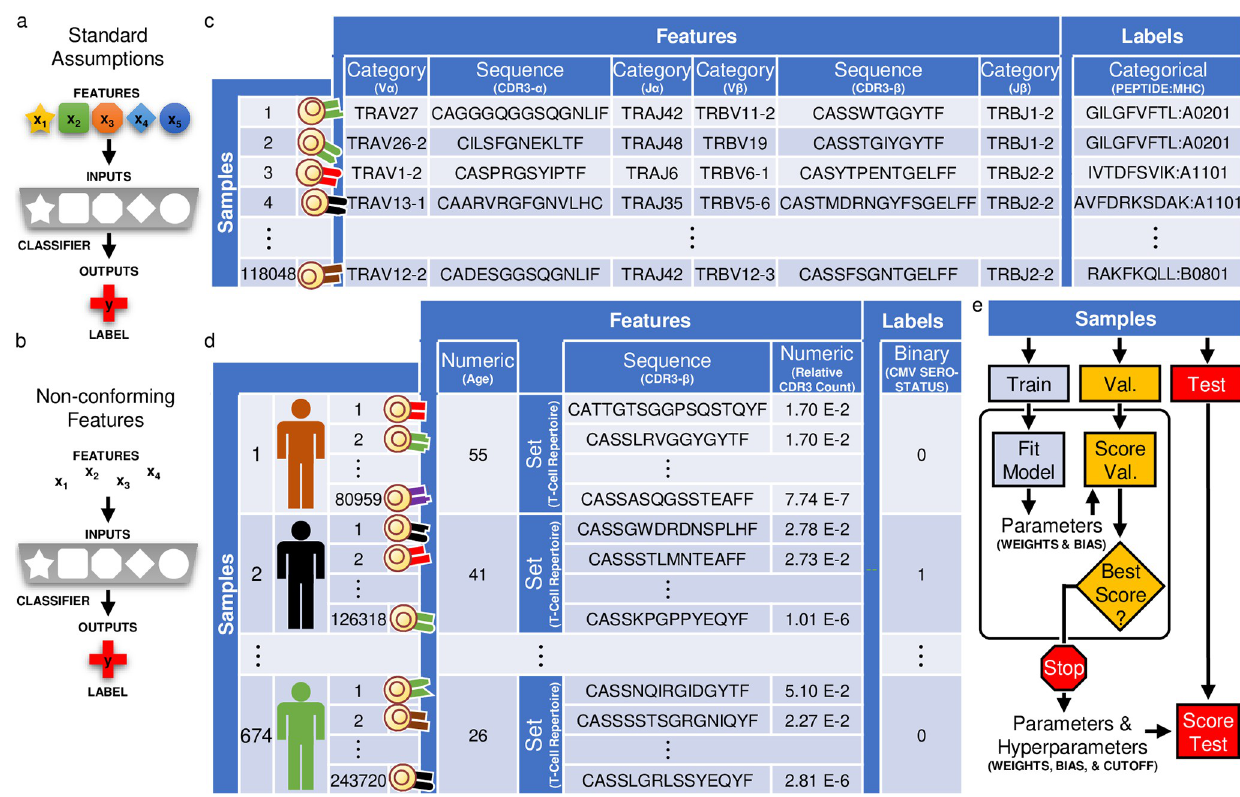
Fig 1. TCRs are examples of non-conforming data. (a) Most statistical classifiers assume a fixed number of features (e.g. five) and that each feature represents the same kind of information across samples (e.g. shape). (b) These assumptions do not hold for non-conforming data. (c) A dataset of TCRs labelled by interaction with disease antigens. The dataset contains the amino acid symbols from regions of the TCR (CDR3) represented as sequences, which are examples of non-conforming data. (d) A dataset of TCR repertoires labelled by CMV serostatus. The dataset contains sequenced TCR repertoires represented as sets made of sequences, which is a different kind of non-conforming data than the previous dataset. (e) Samples are split into a training, validation, and test cohort (for panel c, identical sequences are first collapsed to ensure the same TCR does not appear in multiple cohorts). The training cohort is used to select the weights and biases of each model, the validation cohort is used for model selection, and the test cohort is used for reporting